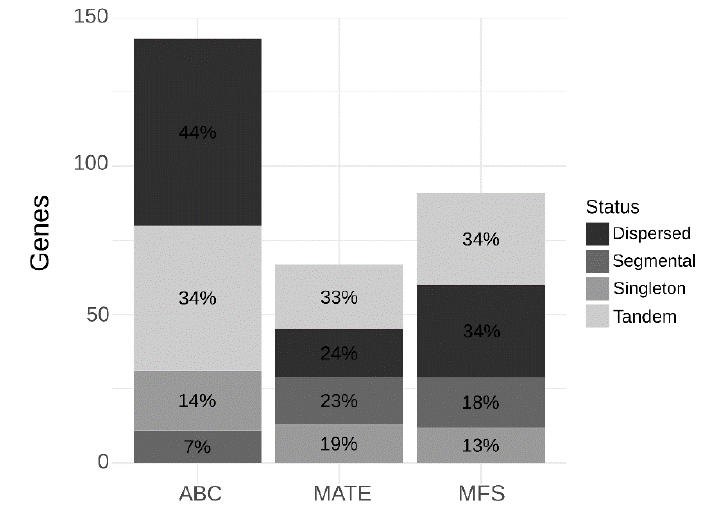
Figure 2. Duplication events of MATE, ABC, and MFS genes in the C. sinensis genome.